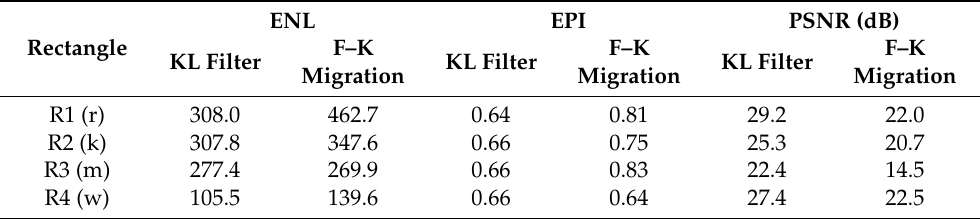
Table 1. Comparisons of quantitative indexes calculated after filtering in the rectangular regions of Line 1 (TSH data; Figure 2).